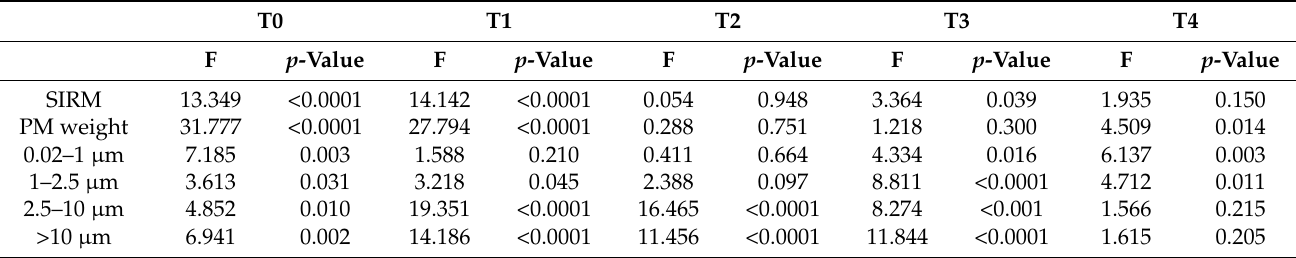
Table 2. Results (SIRM, PM weight, and different grain-size particles (0.02–1 µ m, 1–2.5 µ m, 2.5–10 µ m, and >10 µ m)) of one-way ANOVA performed between three height ranges (L, M, and H) at sites T0–T4. Statistically significant differences ( p < 0.05) are highlighted in